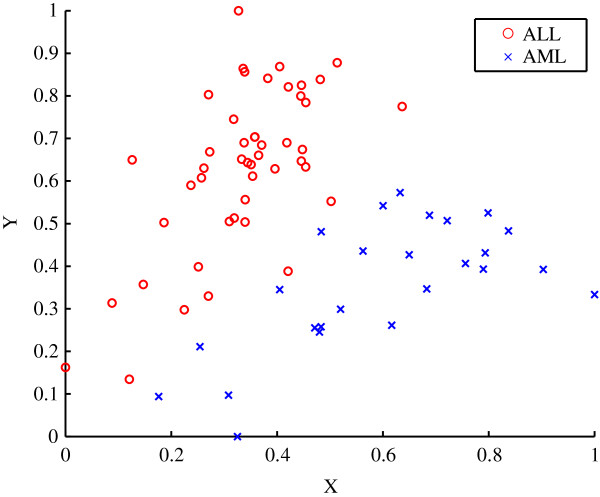
Scatter plot of the a priori classification for the Golub dataset. The two distinct classes of acute lymphoblastic leukaemia (ALL) and acute myeloid leukaemia (AML) are shown.